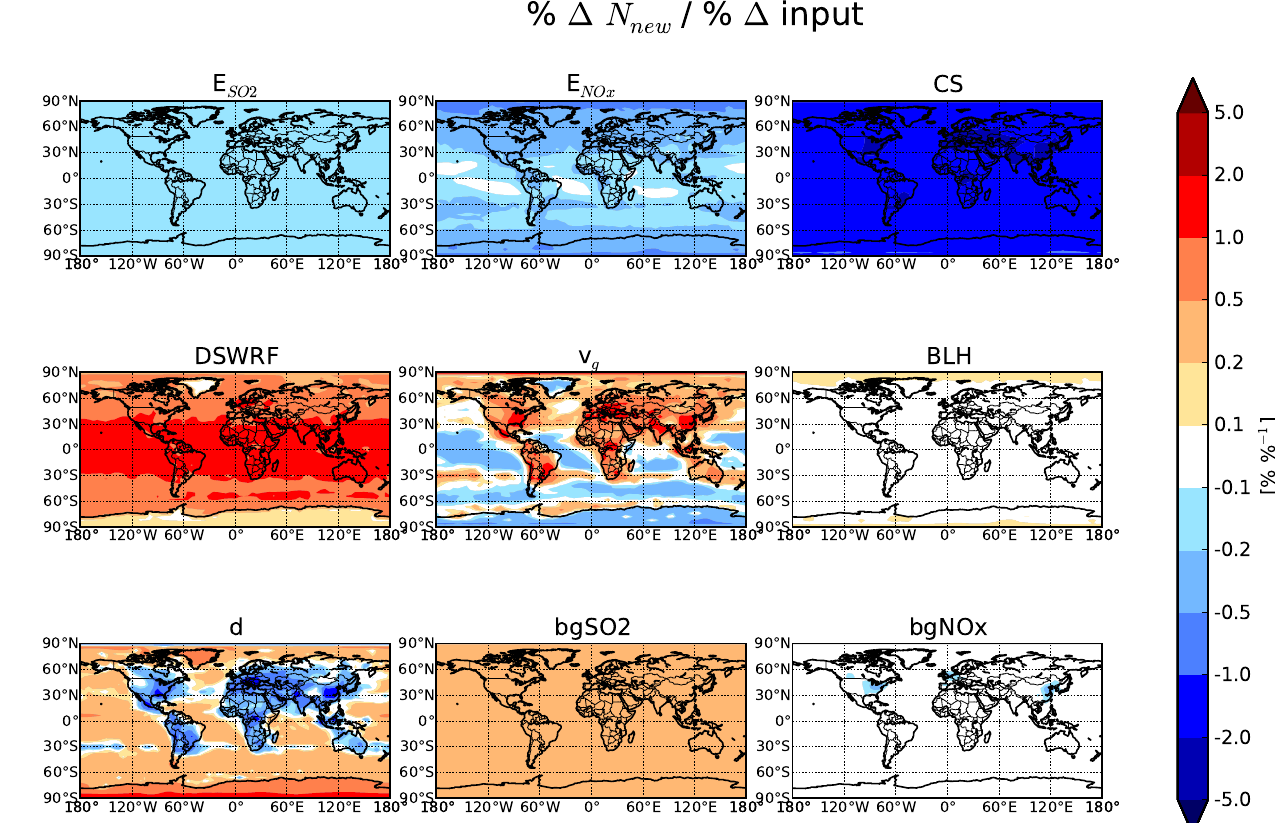
Figure 5. Annually averaged sensitivity of N new to each of the inputs to P6 for simulation P6_yXSOA_Napa, given as the percentage change in the value of N new for a percentage change in the value of the input.